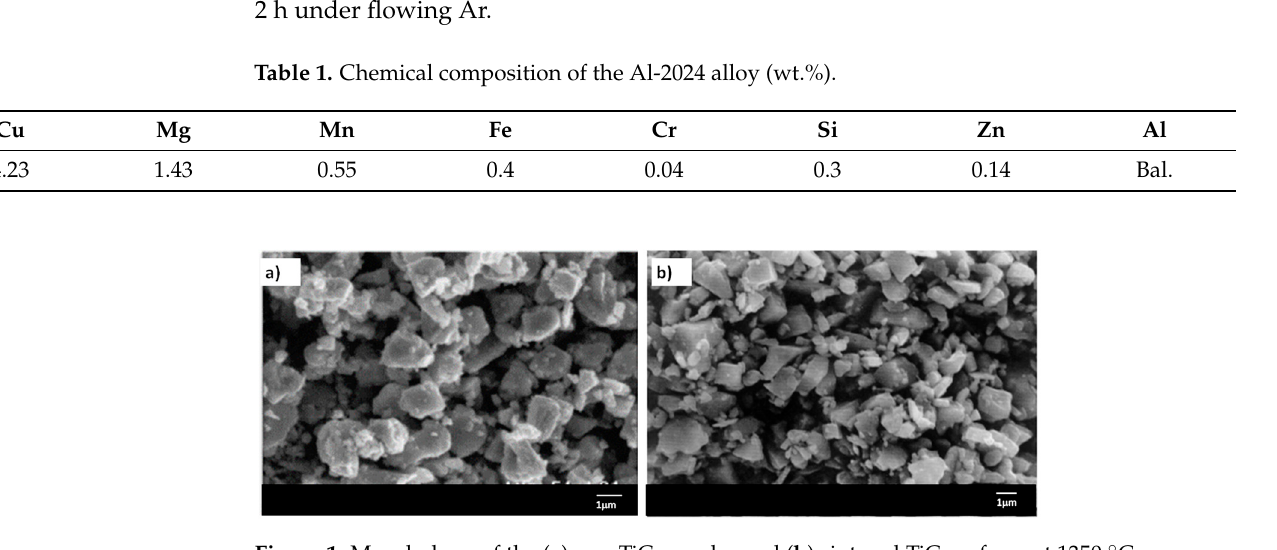
Figure 1. Morphology of the ( a ) raw TiC powder and ( b ) sintered TiC preform at 1350 °C.